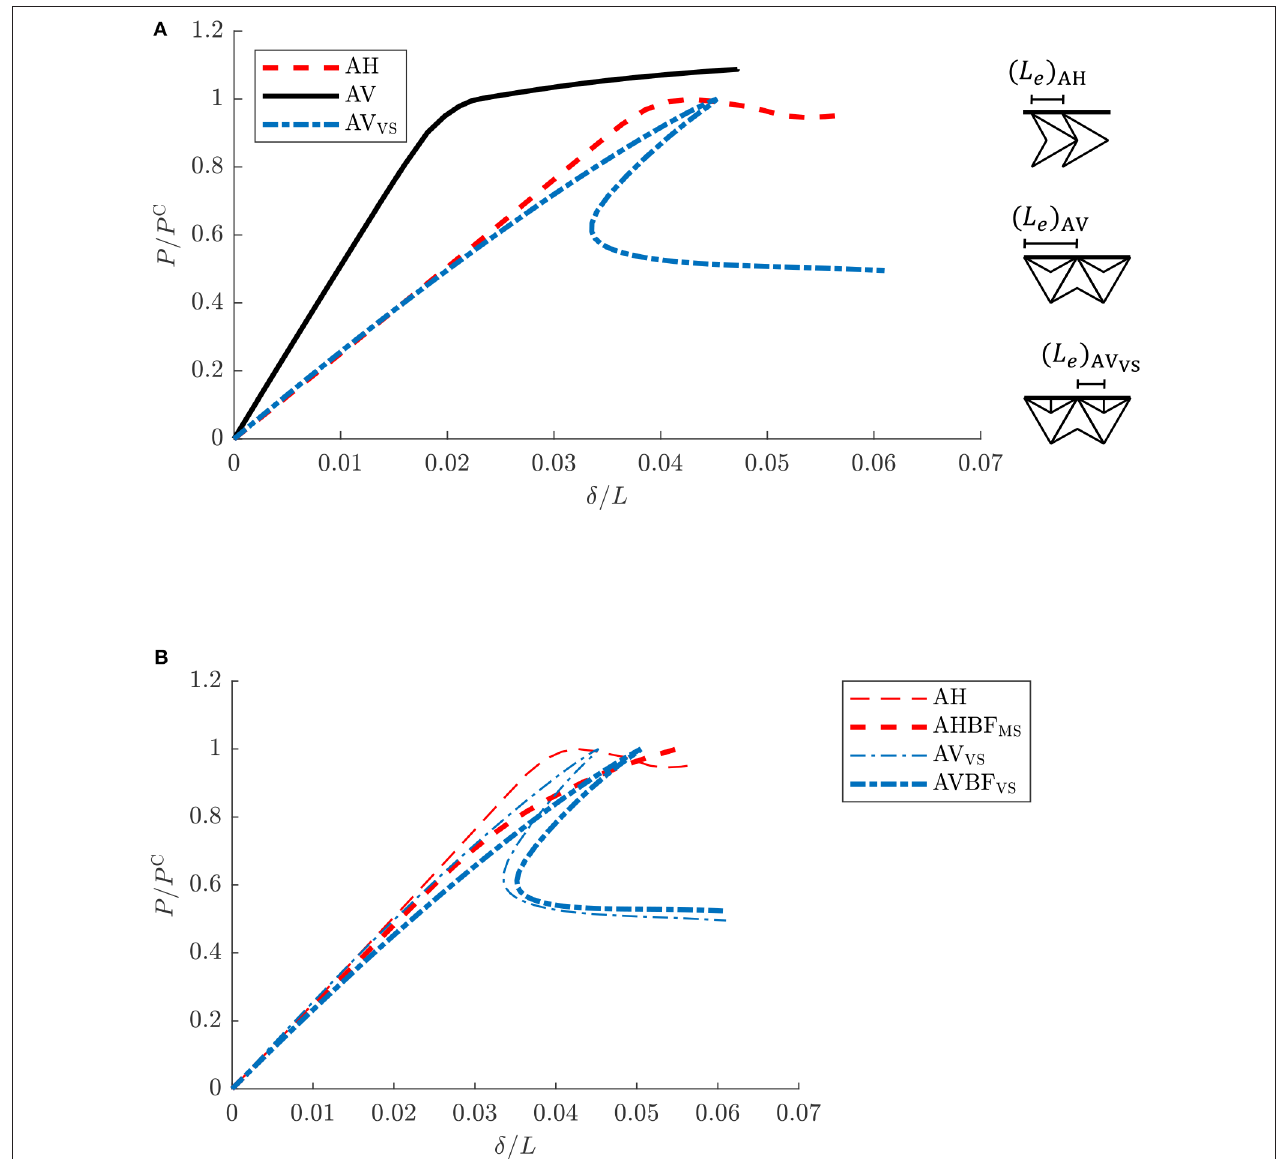
FIGURE 9 | Normalized load vs. normalized axial end-shortening behavior for a set of sandwich panels. (A) P / P C vs. δ/ L for the set of uniform cores: AH, AV, and AV VS . (B) P / P C vs. δ/ L for the cores without disruptions: AH and AV VS ; alongside the cores with disruptions along the midspan or mid-depth: AHBF MS and AVBF VS ,